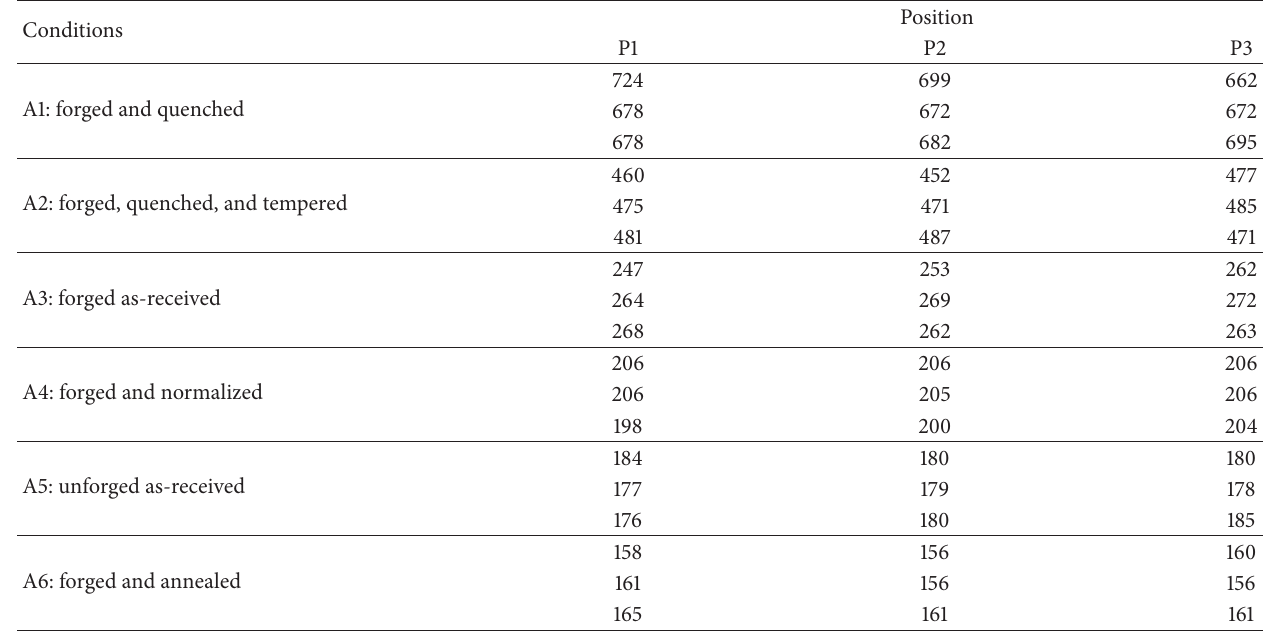
Table 3: Vickers hardness (VH) results.